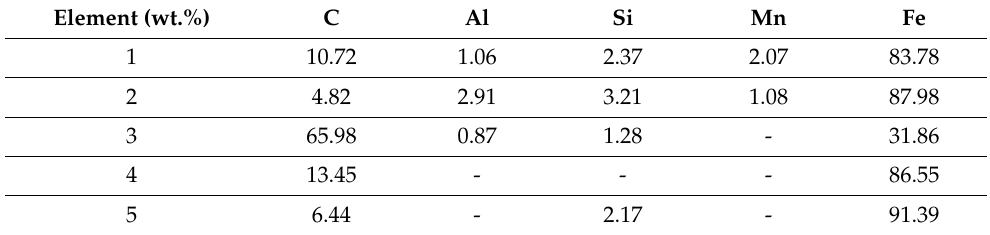
Table 4. Point analysis of elements in the selected areas.